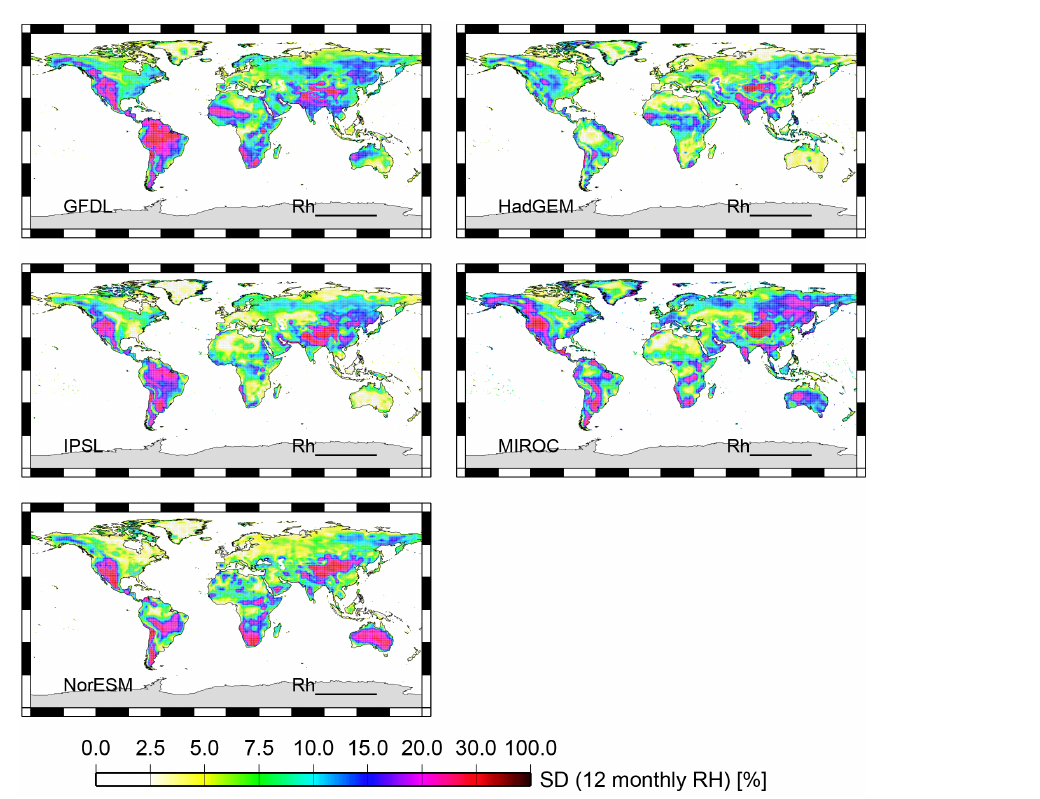
Figure 4. Geographical distribution of the SD from the WATCH data for the relative humidity. The SD was evaluated from 12-month climatological (1971–2000) data for each land